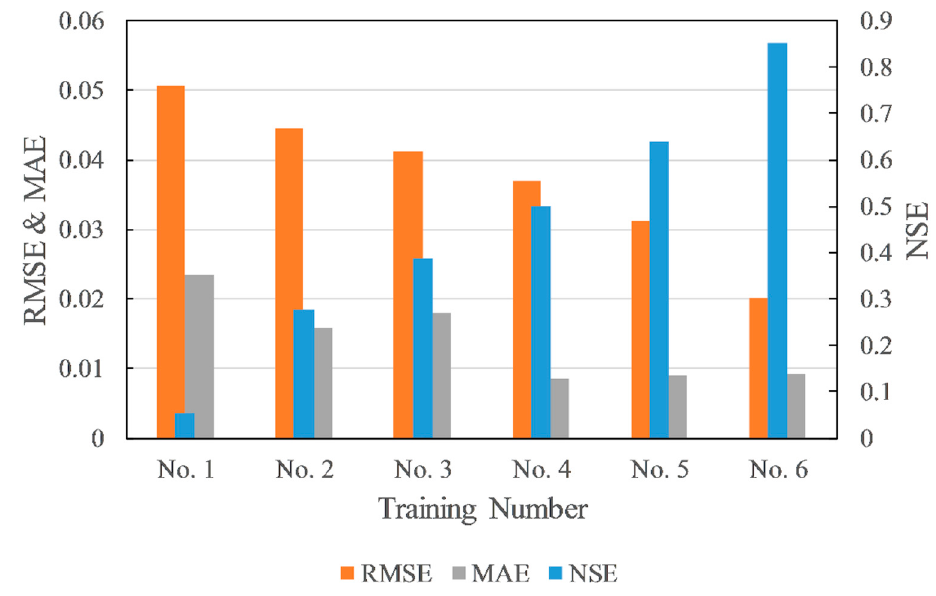
7 of 16 Figure 4. Tank model estimated with 2009 precipitation data. 3. Results and Discussion 3.1. Evaluation Metrics NSE, RMSE, and MAE were tested on several random trainings. The results indicated